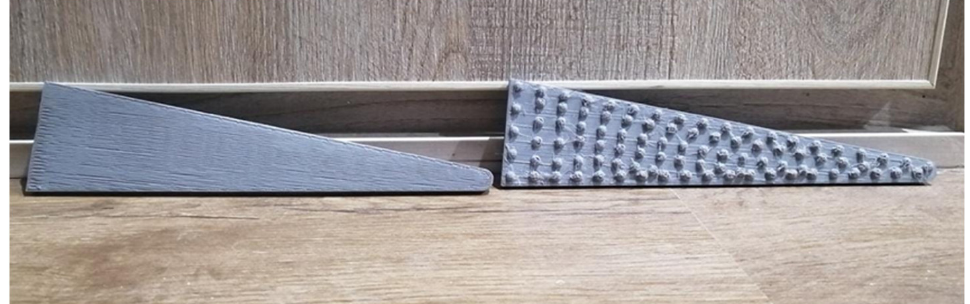
Figure 4. Prototypes of a normal and dimpled section of a turbine blade.